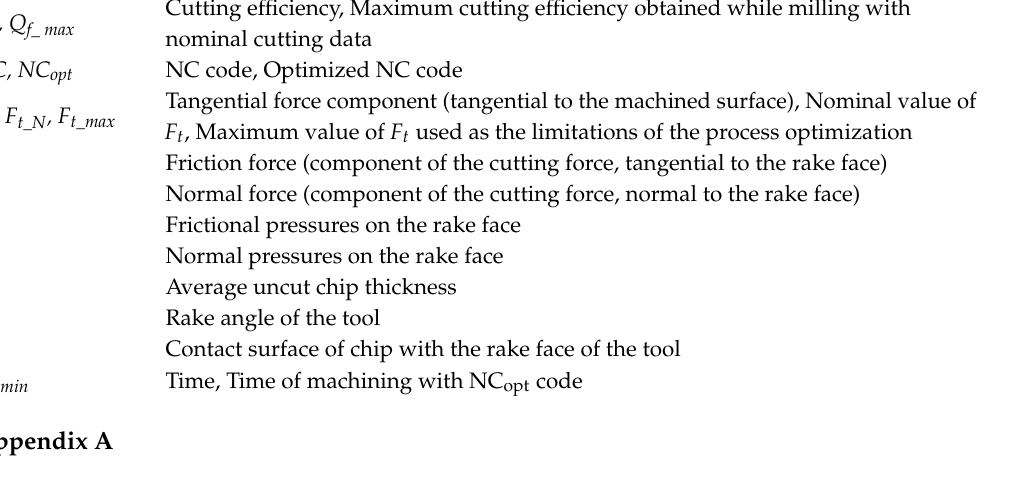
Table A1. Geometry of the milling tool.